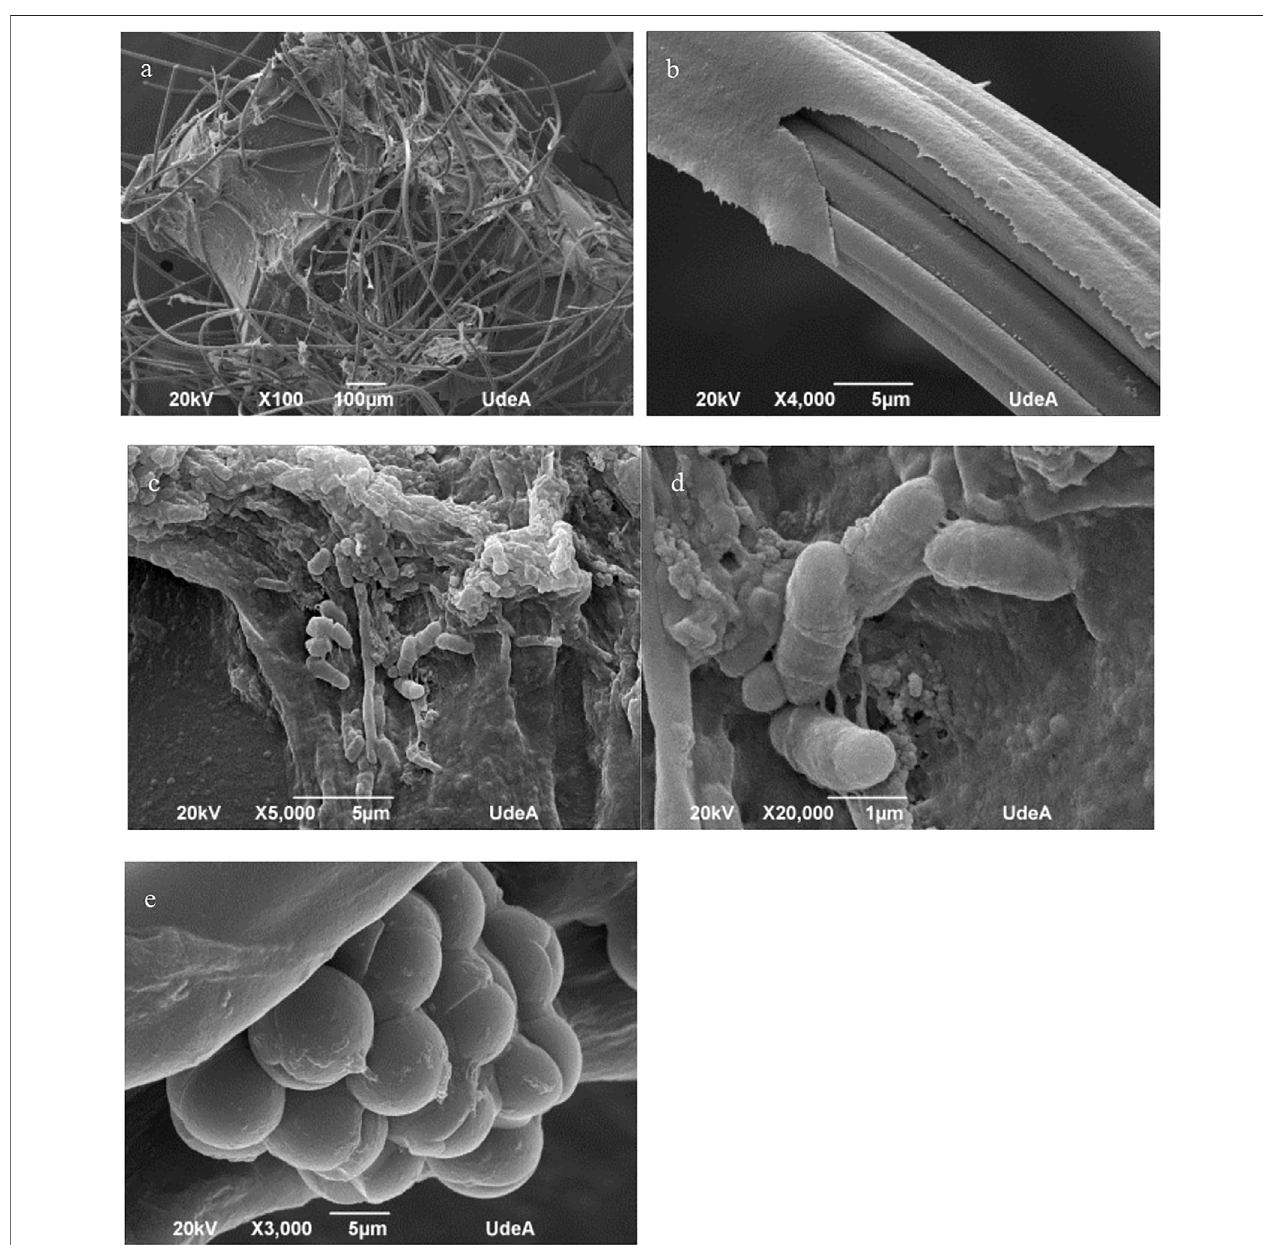
FIGURE 9 | Analysis by scanning electron microscopy of the anode of MFC2. The images show the microscopic changes observed in the carbon felt fi bres after operation for 30 days (A) structure of the carbon felt at X100 magni fi cation; (B) detail of the anode surface fi bres covered by a layer of biological material at 4,000X magni fi cation. (C) Microbial cells embedded in polymeric substance can be seenattached tothe carbon fi bres; (D) bacilliand (E) cocci can be observed attached tothe carbon fi